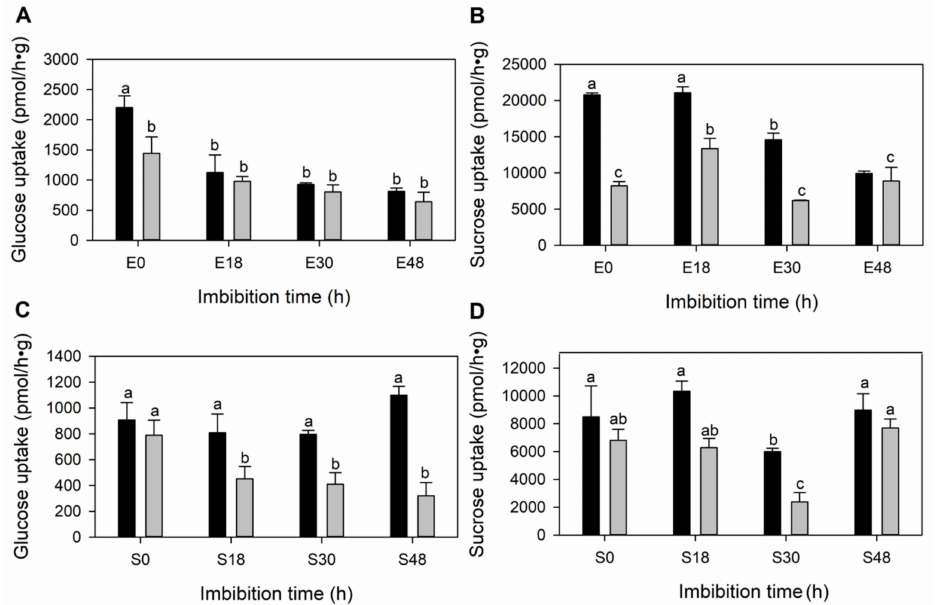
Figure 7. Sugar uptake in embryo axis (E) and scutellum (S) tissue isolated from seeds imbibed at di ff erent times. ( A , B ) Embryo axis, ( C , D ) scutellum, ( A ) and ( C ) 14 C-glucose uptake, ( B ) and ( D